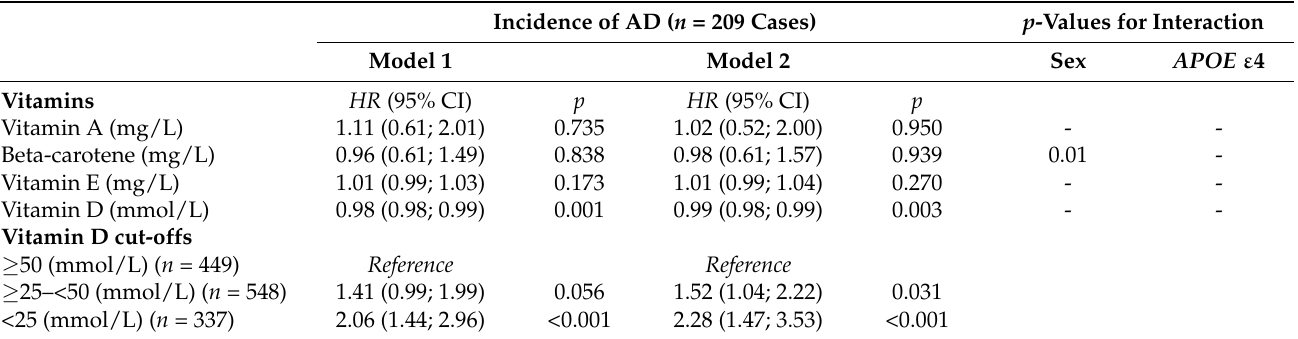
Table 3. Longitudinal associations between blood (serum/plasma) concentrations of vitamins A, D and E and beta-carotene and incident AD over a 7-year follow-up period.